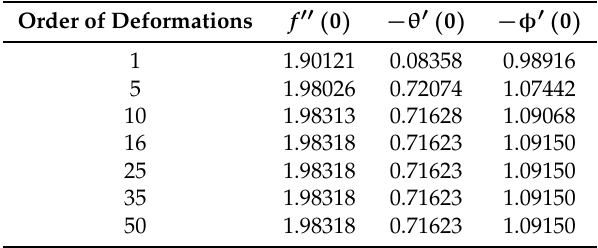
Table 1. HAM solution convergence at the lower disk when S = 0.2, M = Nt = 0.2, Nb = 0.5 and Sq = Le = Pr = 1.0.